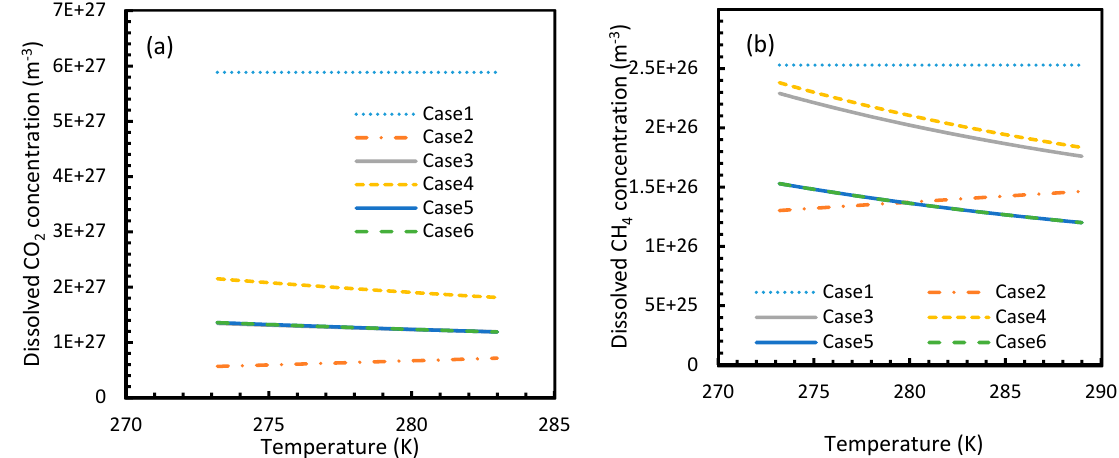
Figure 4. Concentration profiles of dissolved CO 2 ( a ) and CH 4 ( b ) in aqueous phase under isobaric conditions at a reference pressure 30 MPa. The ideal case (Case 1) showed no change in its profile due to the lack of the temperature dependent parameter in its dissolution equation. Similar to Figure 1, the values of Case 5 overlapped with Case 6.